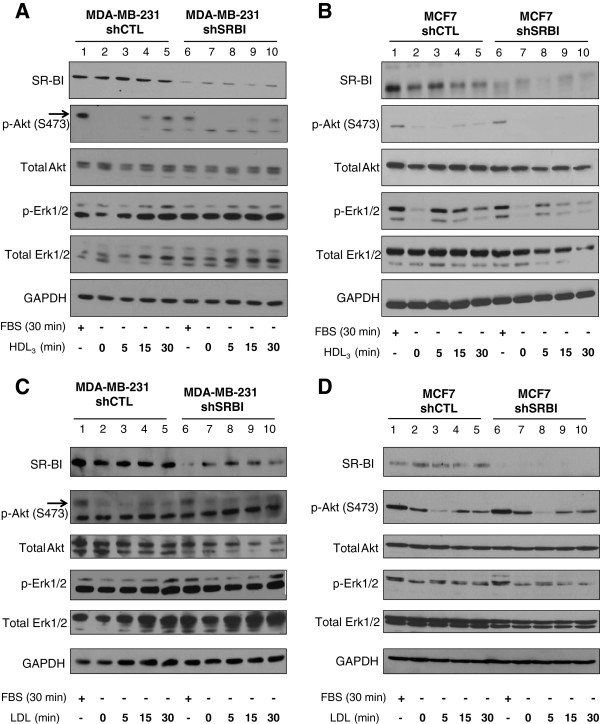
Knockdown of SR-BI attenuates HDL3-induced signal transduction in MDA-MB-231 and MCF7 cells. (A,B) MDA-MB-231 and MCF7 cells were stably transduced by lentiviruses carrying either shRNA against SR-BI (shSRBI) or control shRNA (shCTL). Cells were incubated with either 10% FBS for 30 minutes or with 100 μg/ml HDL3 for the indicated times. Whole-cell lysates were analyzed by Western blot for the indicated proteins. The arrow indicates the protein corresponding to phospho-Akt. GAPDH was used as loading control. (C,D) MDA-MB-231 and MCF7 cells were stably transduced by lentiviruses carrying either shRNA against SR-BI (shSRBI) or control shRNA (shCTL). Cells were incubated with either 10% FBS for 30 minutes or with 100 μg/ml LDL for the indicated times. Whole-cell lysates were analyzed by Western blot for the indicated proteins. The arrow indicates the protein corresponding to phospho-Akt. GAPDH was used as loading control. Note that, in panel C, the image was spliced (between lines 5 and 6) to eliminate an irrelevant line.